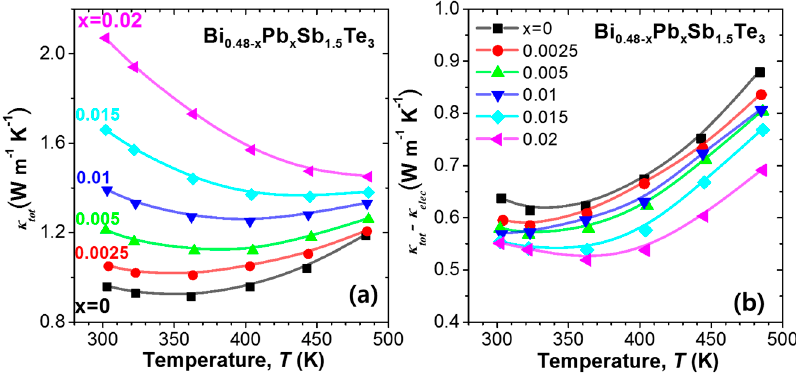
Figure 2. Temperature dependence of ( a ) total thermal conductivity ( κ tot ) and ( b ) ( κ tot - κ elec ) for Bi 0.48- x Pb x Sb 1.52 Te 3 ( x = 0, 0.0025, 0.005, 0.01, 0.015, and 0.02). The κ tot data are taken from [9].